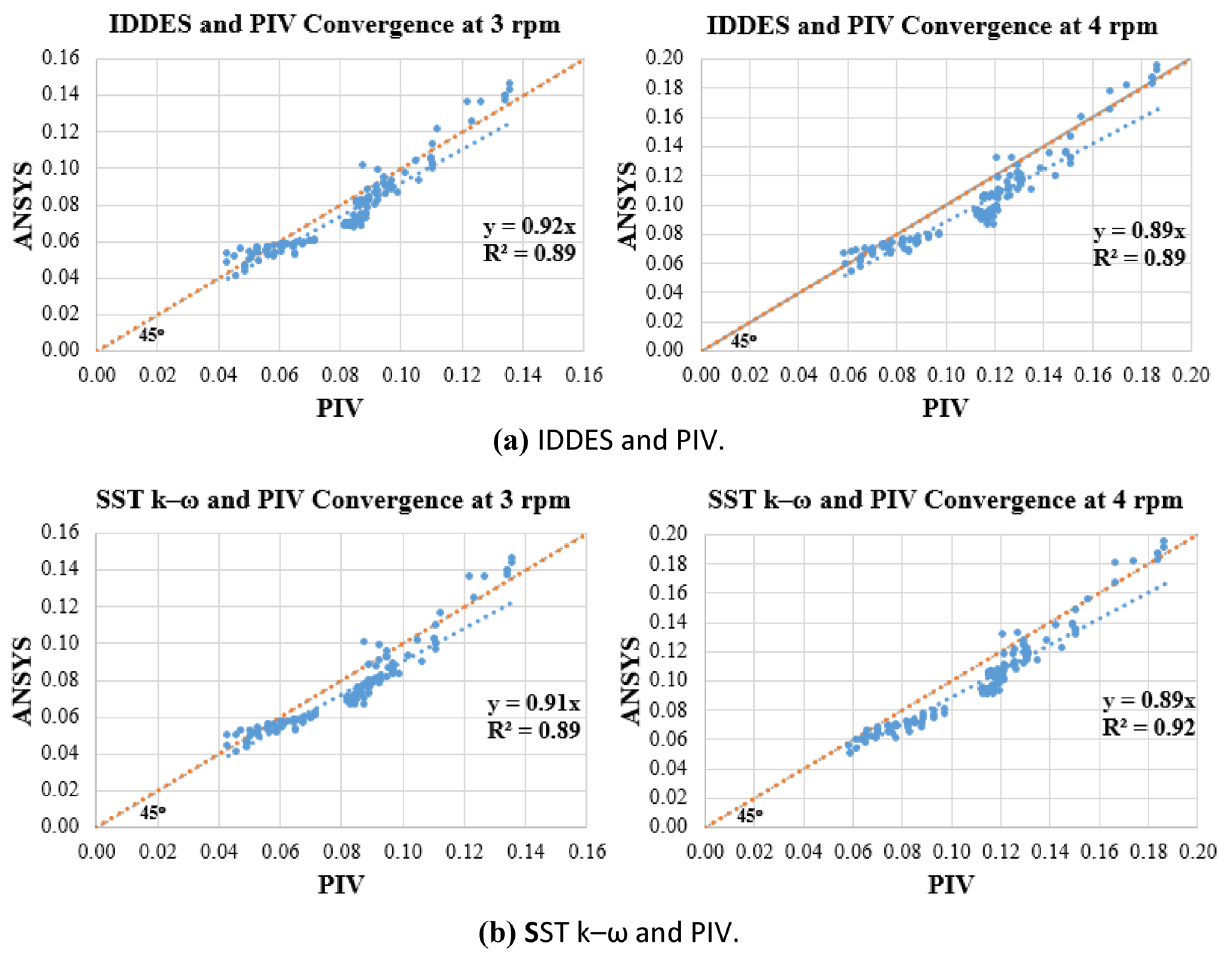
Figure 9. Goodness-of-fit evaluation of computed velocities and PIV